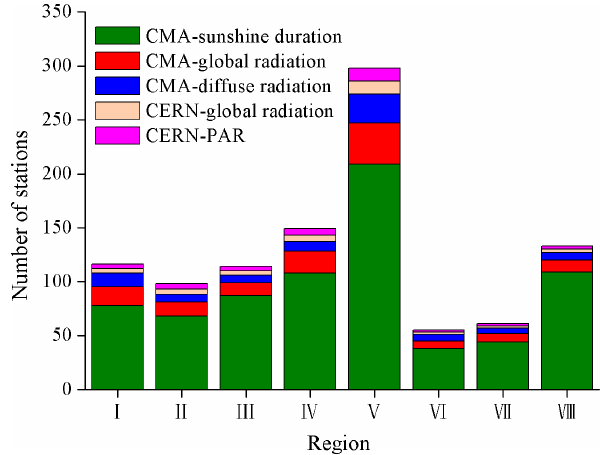
Figure 6. The numbers of stations observing sunshine duration, global radiation, diffuse radiation, and photosynthetically active ra- diation (PAR) for each region (I: Northwest China; II: Inner Mon- golia; III: Northeast China; IV: North China; V: Central China; VI: South China; VII: Southwest China; VIII: Qinghai–Tibet Plateau).